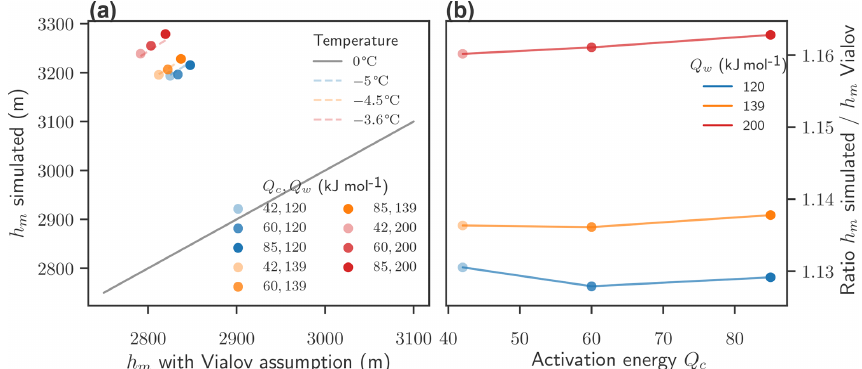
Figure 5. Comparison of simulated equilibrium thickness with analytical results. (a) Dots: maximal thickness h m of the simulated poly- thermal ice sheet versus the analytical solution for the maximal thickness h m of a temperate Vialov profile with the same flow parameters and accumulation rate. Colors indicate the parameter combination. The grey line indicates identity. Short dashed lines indicate the analytical h m with a temperature lower than the pressure melting point versus h m at the pressure melting point with the same flow parameters and accumulation rate. The temperature which fits the simulated results best is indicated in the legend. (b) Ratio of the simulated h m to the analytic h m (assuming a temperate ice sheet) versus Q c for different parameter combinations of Q c and Q w . The value of Q w is indicated by the